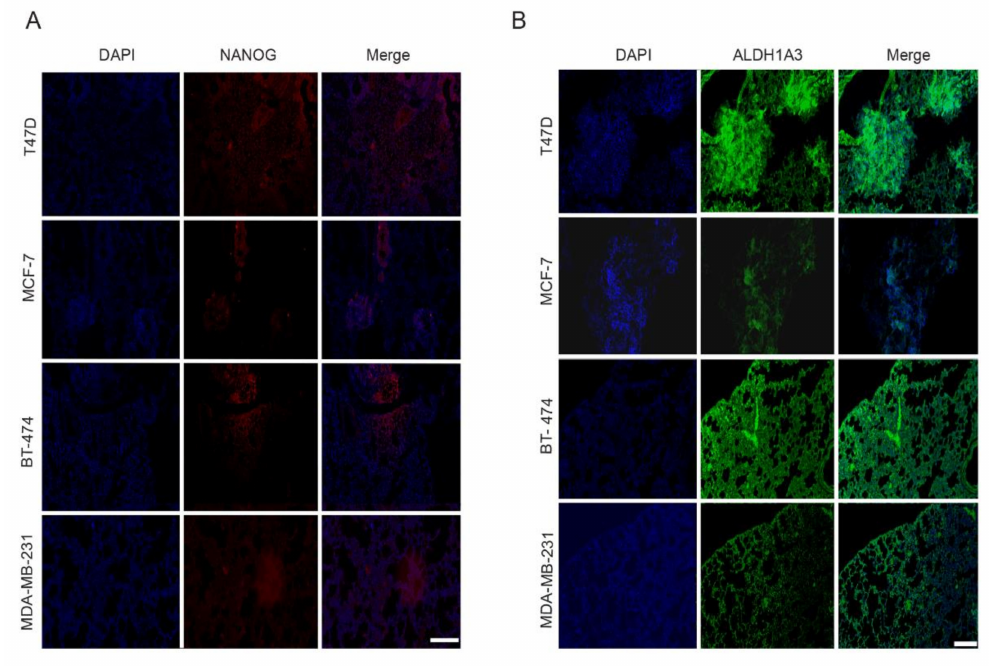
Figure 8. Luminal CD44 − / low / CD24 − / low cells express NANOG and ALDH1A3 at the metastasis site. Representative images of double immunohistostained metastatic sections of lungs from NSG mice. ( A ) DAPI (blue), anti-NANOG (red) ( B ) DAPI (blue), anti-ALDH1A3 (green). Scale bar = 200 µ